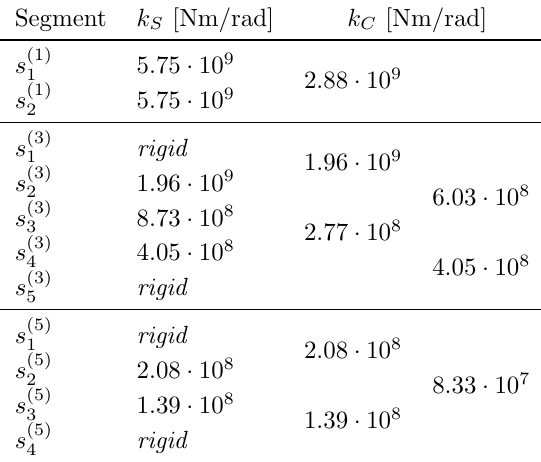
Table 2: Segment and connection stiffnesses.